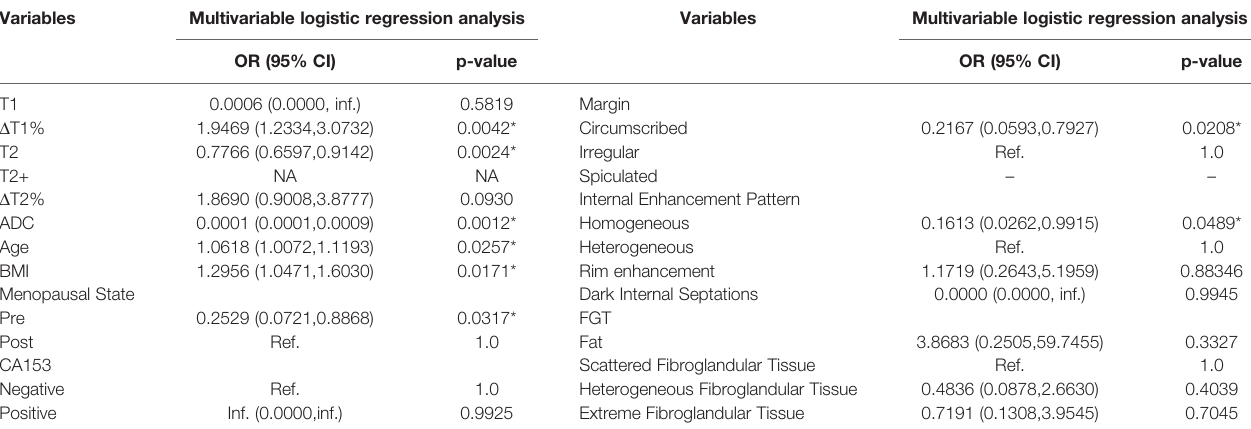
TABLE 3 | Parameters associated with breast cancer diagnosis in multivariable logistic regression analysis. Variables Multivariable logistic regression analysis